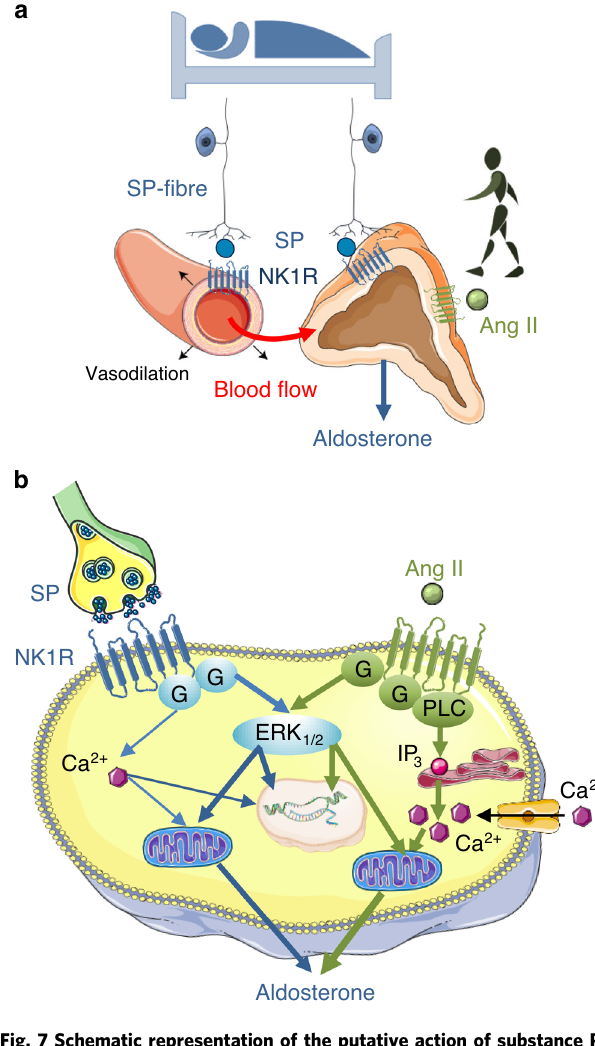
Fig. 7 Schematic representation of the putative action of substance P (SP) on aldosterone production by the human adrenal gland. a SP may stimulate aldosterone secretion through both an indirect vascular effect leading to an increase in adrenal blood fl ow and a direct action on adrenocortical cells, the two mechanisms being mediated by the NK1 receptor (NK1R). The action of SP seems to be complementary to that of Ang II which is involved in the aldosterone response to upright posture while SP may mainly control basal aldosterone production. b At the cellular level, binding of SP to the NK1R expressed by zona glomerulosa cells induces an activation of the ERK pathway but has a minor effect on the calcium signalling pathway in contrast to angiotensin II (Ang II) which strongly activates the two transduction mechanisms. Schemas created using medical diagrams available from https://smart.servier.com under a CC BY 3.0 licence